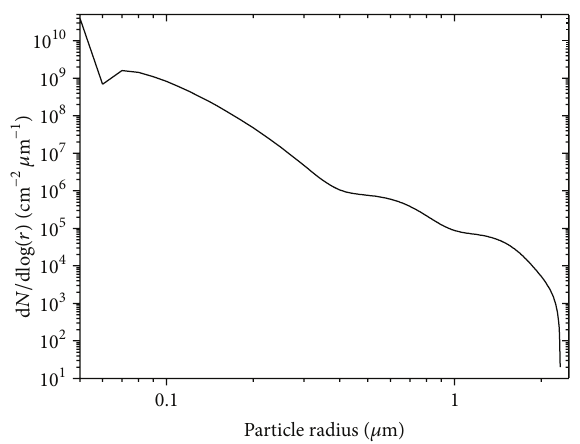
Figure 4: The averaged size distribution of the whole observation